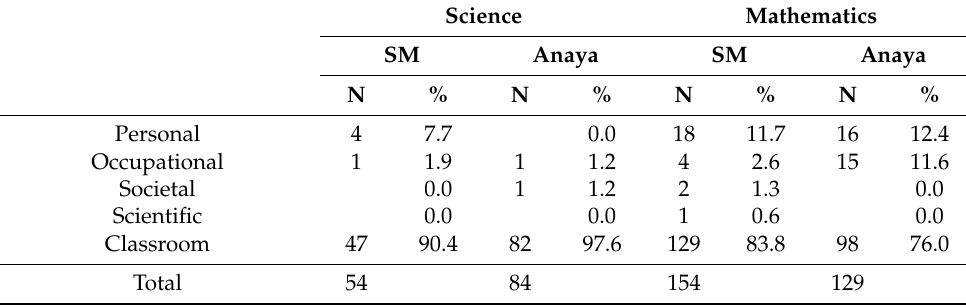
Table 7. Phenomenology by subject and